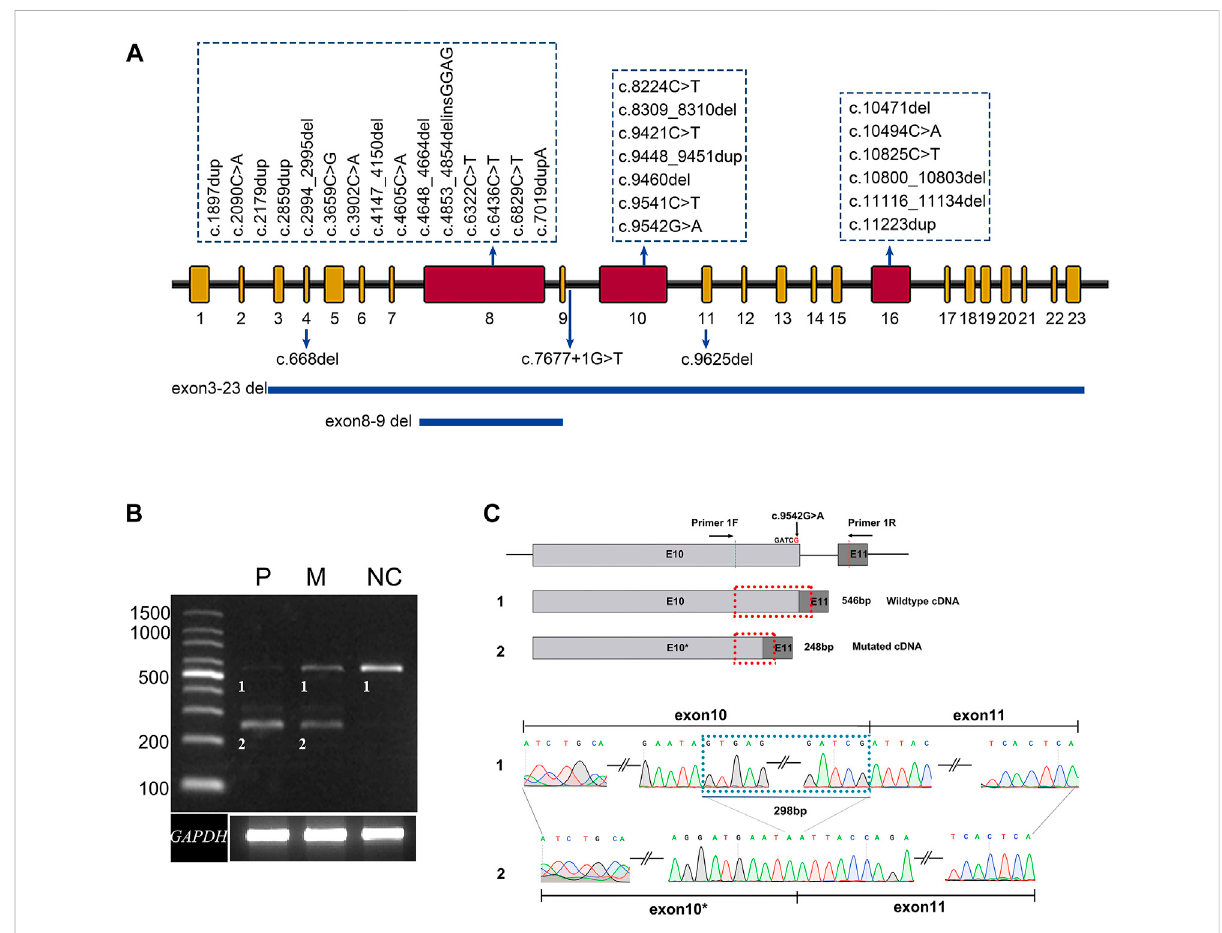
FIGURE 1 Summary of thevariants identi fi ed in thisstudy. (A) The distributionof 33 distinct variants of ALMS1 inthis study. (B) Agarosegel electrophoresis displays the RT-PCR products for ALMS1 mRNA transcripts and GAPDH from the lymphocytes of patient 010737 (P), the patient ’ s mother (M), and a normal control (NC). (C) A schematic diagram shows the position of the novel variant and the cryptic donor site. A sequence chromatogram of the wild-type and aberrant transcripts show a lack of the last 298 bp of exon 10 in the